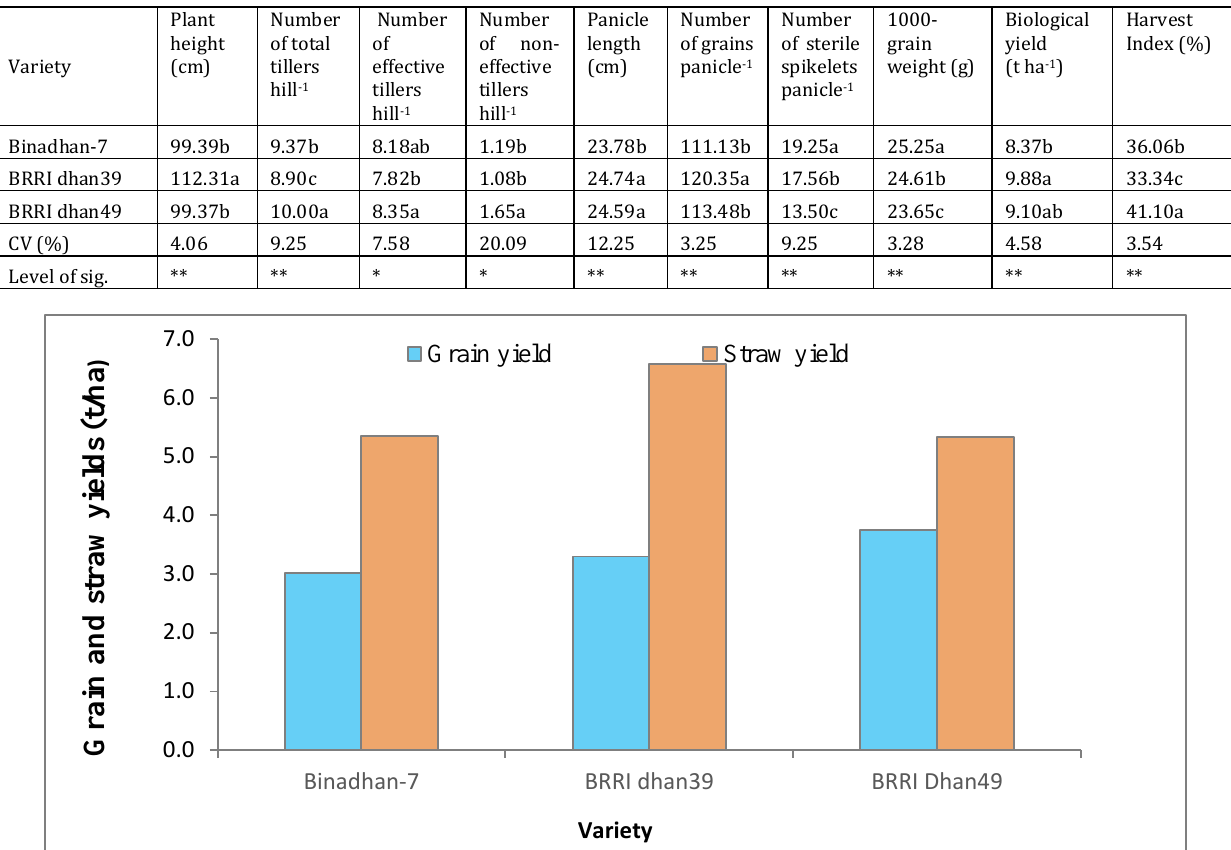
Figure 1: Relation between variety with grain yield and straw yield